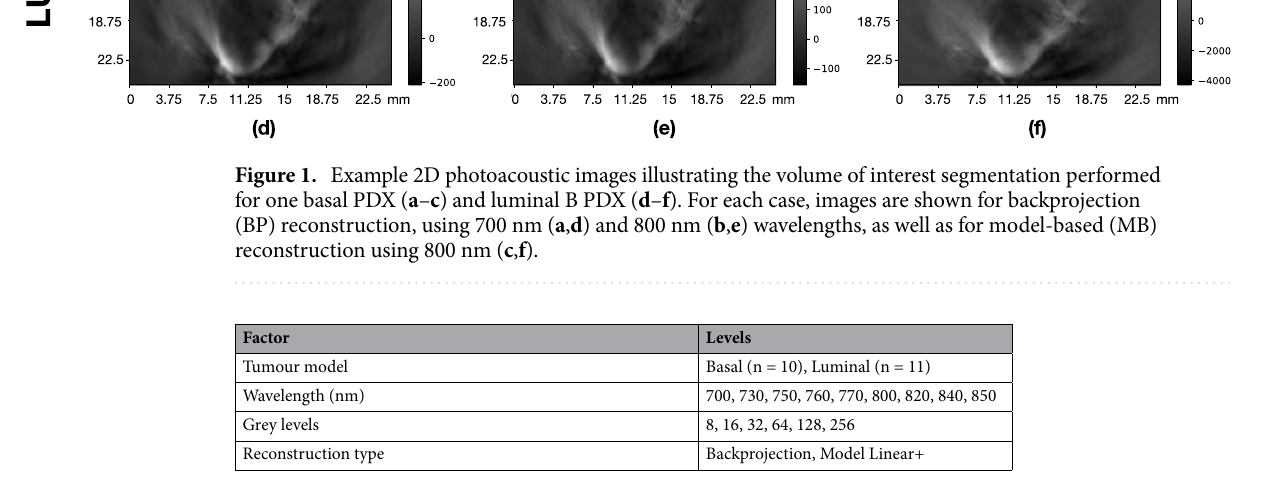
Table 1. Factors investigated and their levels A randomly selected luminal model was left out of the analysis to get a balanced design. The result was 2160 VOIs for analysis.